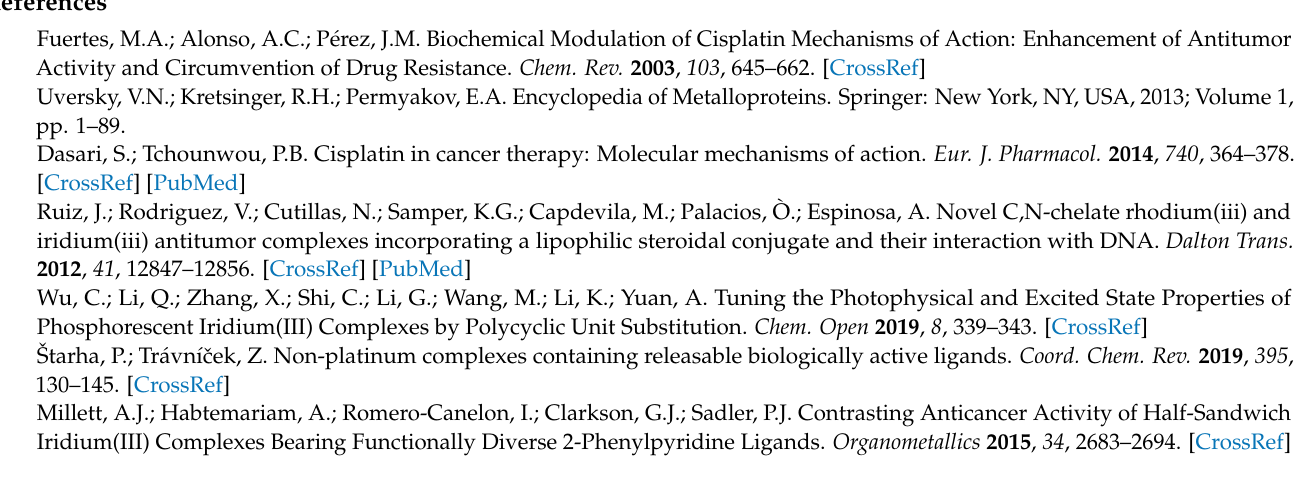
quenching of DAPI-CT DNA (C = 5 × 10 − 5 M) by IrPCp, IrPNr, IrPLm and IrPSf (molar ratios 0.5, 1, 1.5, 2, 3, 4, 5, 6, 7, 8, 9, 10) in 50 mM pH 7.4 phosphate buffer (axis: y—fluorescence intensity; x—wavelength), Figure S3. Fluorescence quenching of DAPI-CT DNA (C = 5 × 10 − 5 M) by PCp, PNr, PLm and PSf (molar ratios 0.5, 1, 1.5, 2, 3, 4, 5, 6, 7, 8, 9, 10) in 50 mM pH 7.4 phosphate buffer (axis: y—fluorescence intensity; x—wavelength), Figure S4. Fluorescence quenching of DAPI-CT DNA (C = 5 × 10 − 5 M) by IrPCp, IrPNr, IrPLm and IrPSf (molar ratios 0.5, 1, 1.5, 2, 3, 4, 5, 6, 7, 8, 9, 10) in 50 mM pH 7.4 phosphate buffer (axis: y—fluorescence intensity; x—wavelength), Figure S5. Fluorescence quenching of HSA (C = 5 × 10 − 5 M) by IrPCp, IrPNr, IrPLm and IrPSf (molar ratios 0.5, 1, 1.5, 2) in 50 mM pH 7.4 phosphate buffer (axis: y—fluorescence intensity; x—wavelength), Figure S6. Fluorescence quenching of apo-Tf (C = 3.6 × 10 − 6 M) by IrPCp, IrPNr, IrPLm and IrPSf (molar ratios 0.5, 1, 1.5, 2, 3, 4, 5, 6, 7, 8, 9, 10) in 50 mM pH 7.4 phosphate buffer (axis: y—fluorescence intensity; x—wavelength), Figure S7. Fluorescence quenching of apo-Tf (C = 3.6 × 10 − 6 M) by PCp, PNr, PLm and PSf (molar ratios 0.5, 1, 1.5, 2, 3, 4, 5, 6, 7, 8, 9, 10) in 50 mM pH 7.4 phosphate buffer (axis: y—fluorescence intensity; x—wavelength). Figure S8. Agarose gel electrophoresis of pBR322 plasmid cleavage by H 2 O 2 in different